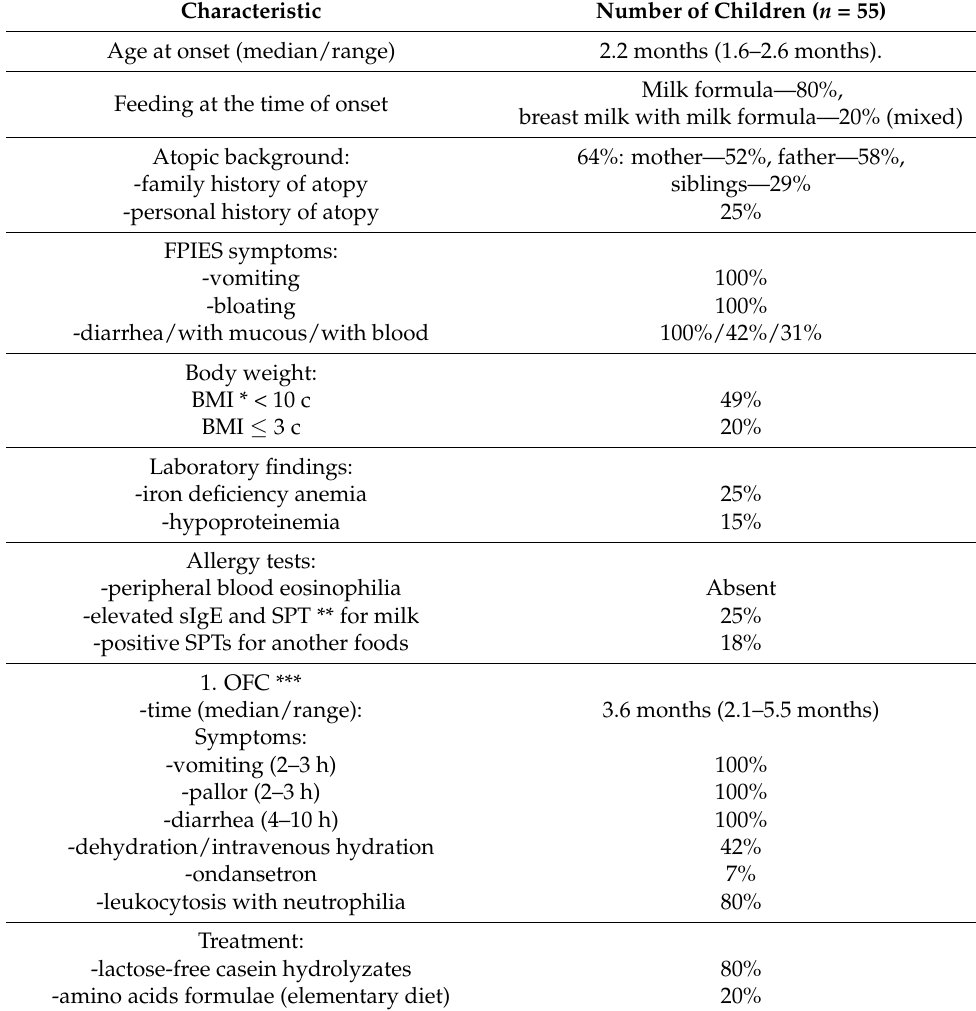
Table 1. Characteristics of children from the study group with chronic food protein-induced entero- colitis syndrome (FPIES) dependent on cow’s milk protein intake in the study group of children.